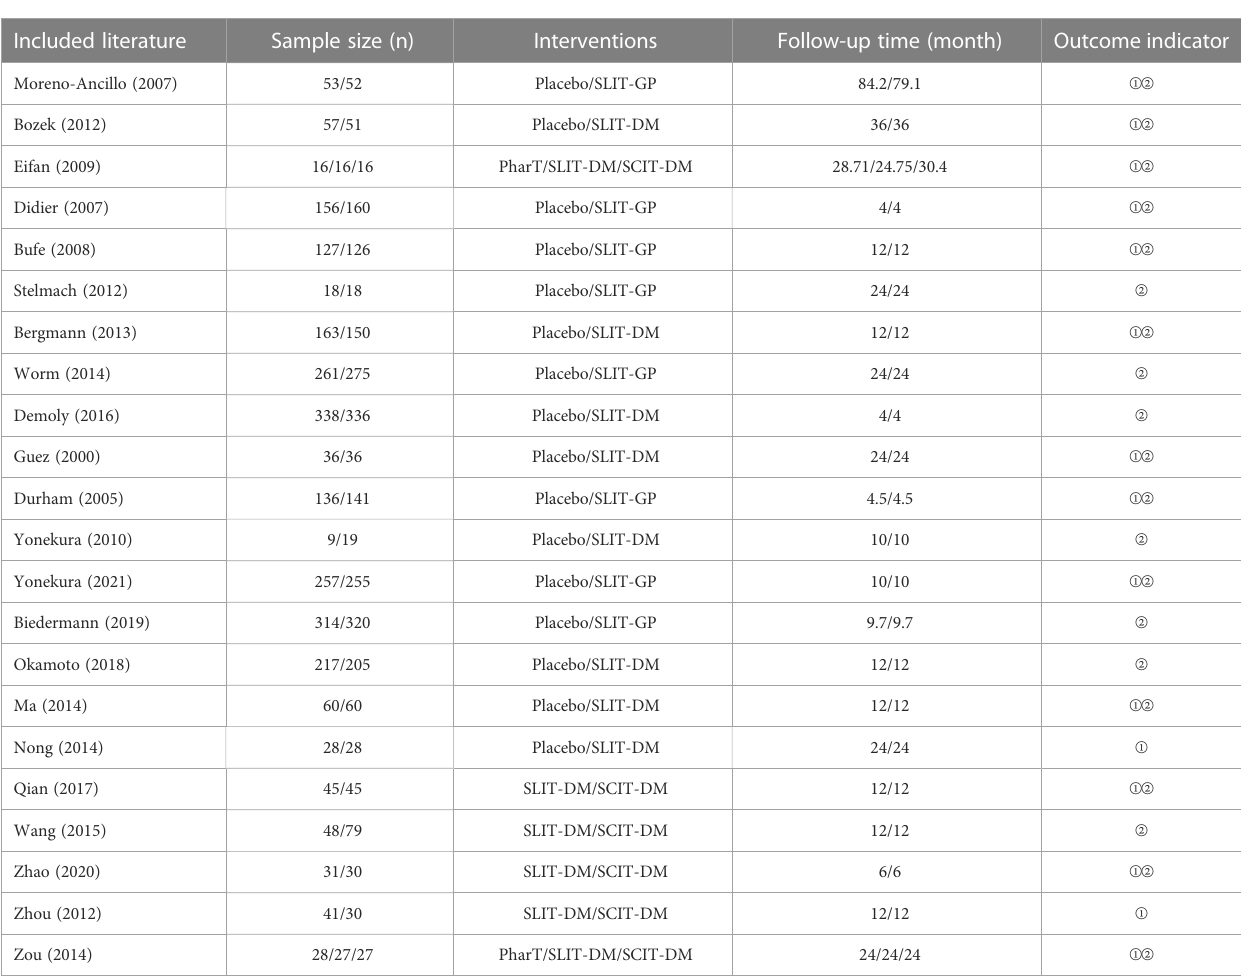
TABLE 1 Basic characteristics of the included